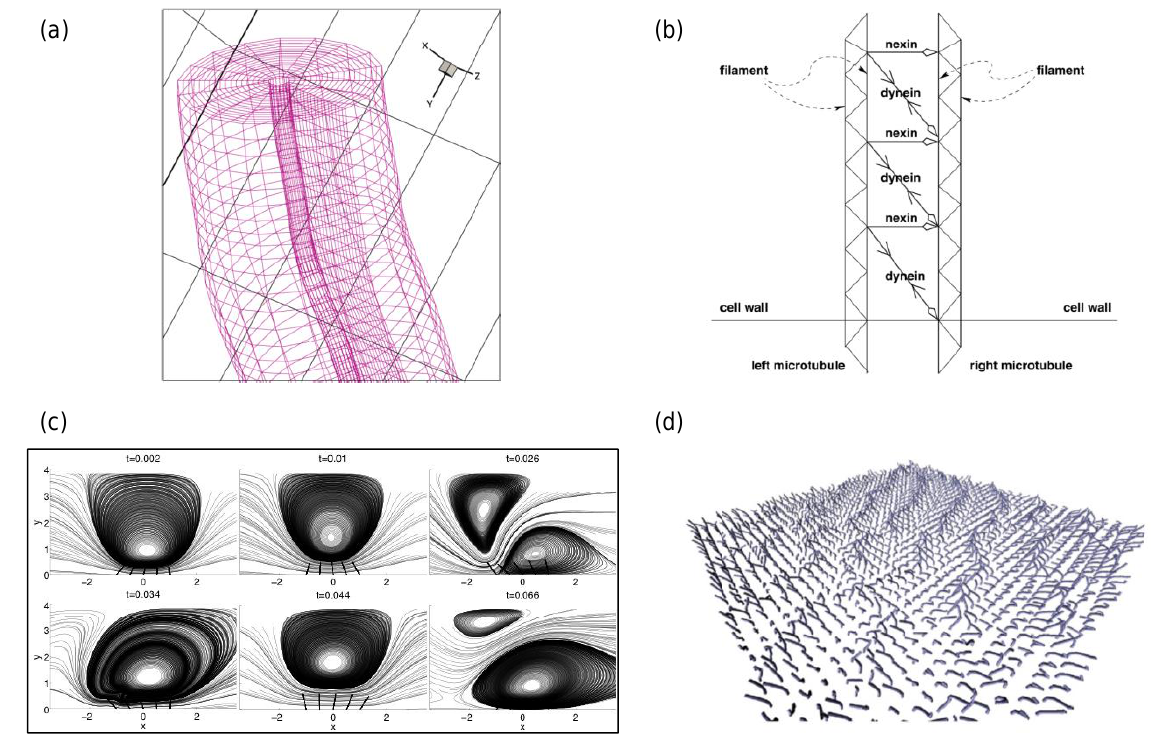
Figure 6. ( a ) The cilium modeled as a finite element beam and the nearby body-fitted grid, from Mitran [85] with permission; ( b ) the cilium modeled as an elastic spring network, from Yang, Dillon and Fauci [87] with permission; ( c ) streamlines in the fluid flow induced by five cilia (rods) at a sequence of times, from Xu and Jiang [34] with permission; ( d ) snapshot of an large array of beating cilia, from Elgeti and Gompper [88] with permission.